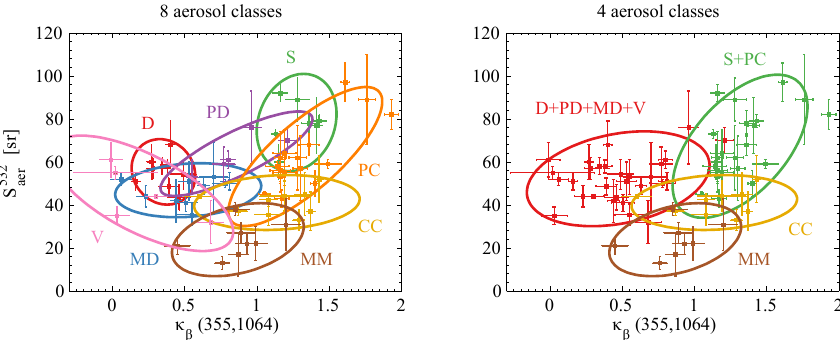
Figure 5. Colored pre-specified classes and 90% confidence ellipses for 8 and 4 aerosol classes. The error bars correspond to the standard deviation of the selected mean intensive properties. CC stands for clean continental, D stands for dust, MD stands for mixed dust, MM stands for mixed marine, PD stands for polluted dust, PC stands for polluted continental, S stands for smoke, and V stands for volcanic particles.